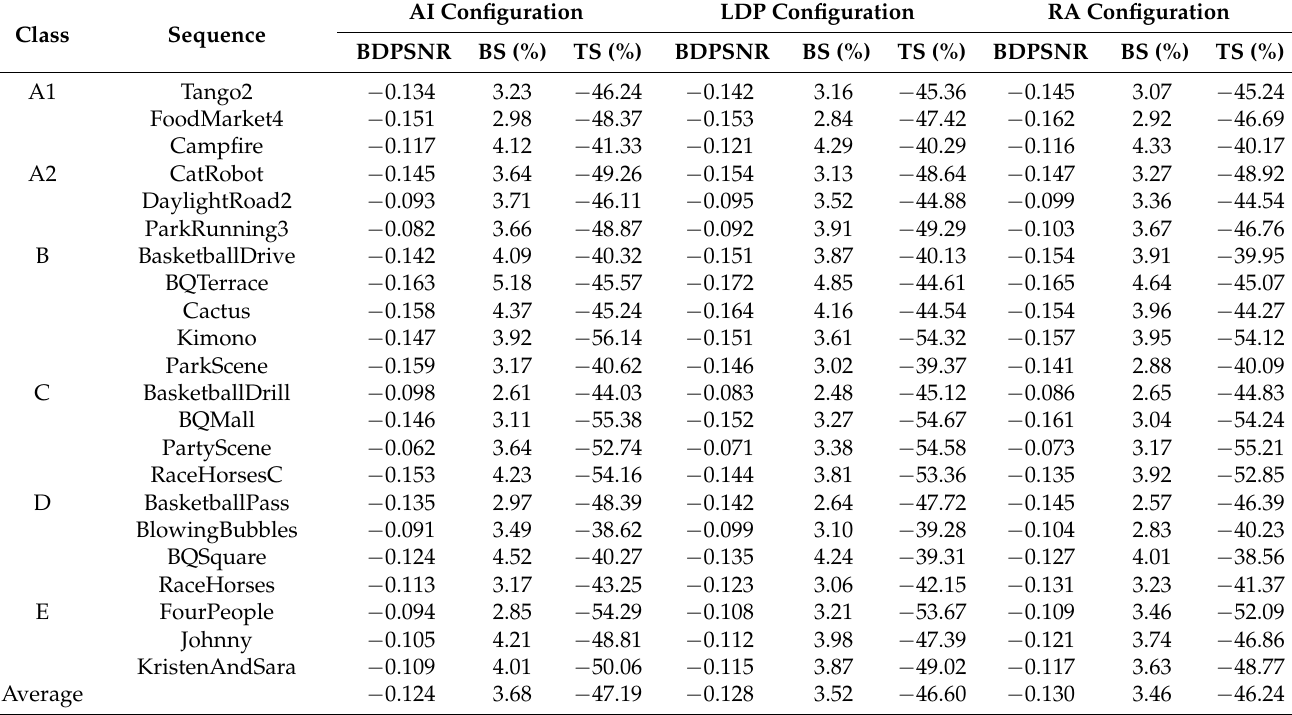
Table 5. Performances of the overall algorithm under AI, LDP, and RA configurations. AI